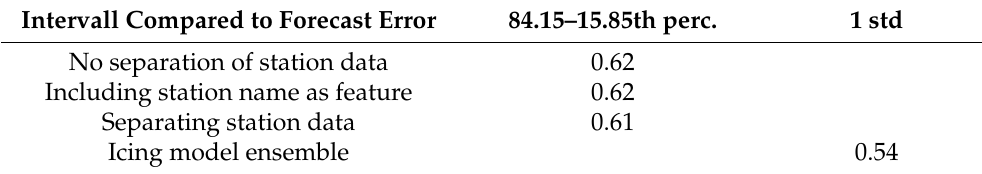
Table 4. Average correlation (Pearson correlation) between forecast error and the 84.15–15.85th percentile interval for the three station data separating options and between forecast error and one standard deviation forecasted by the icing model ensemble utilised in Molinder et al. [8]. Intervall Compared to Forecast